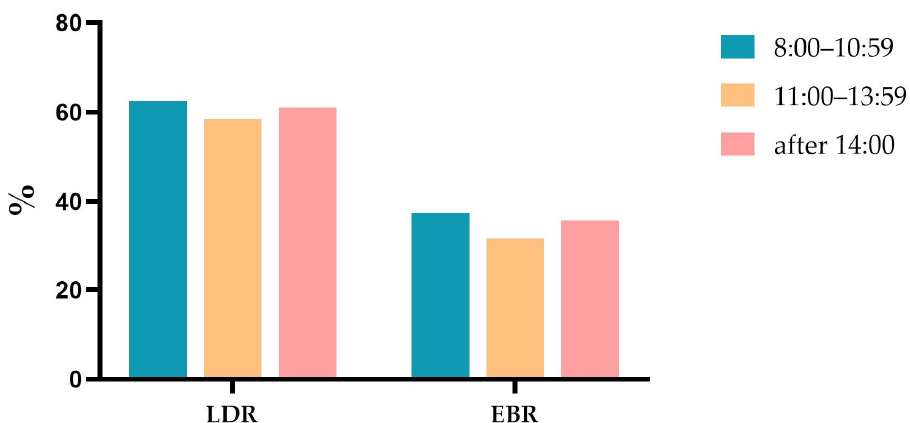
Figure 2. The comparison of LDR and EBR in three shifts. LDR, lesion detection rate; EBR, endoscopy biopsy rate.